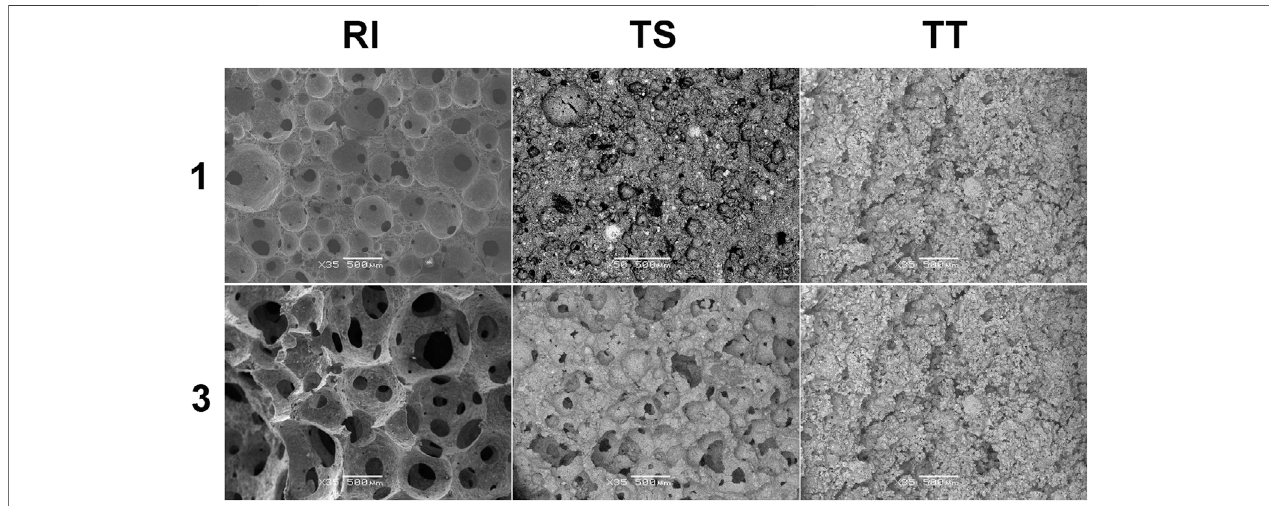
FIGURE 5 | Representative SEM image of alkali-activated foams cured at 70 ° C (RI, TS, and TT fl y ash, 1 and 3 represent the amount of foaming and stabilizing agents used).